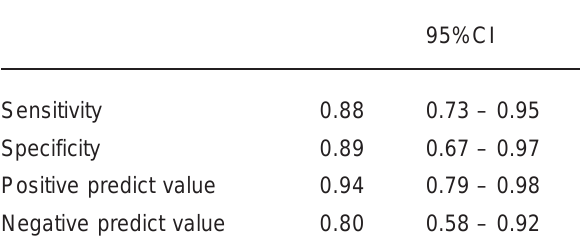
TABLE 3- Sensitivity, specificity, positive and negative predictive values of the